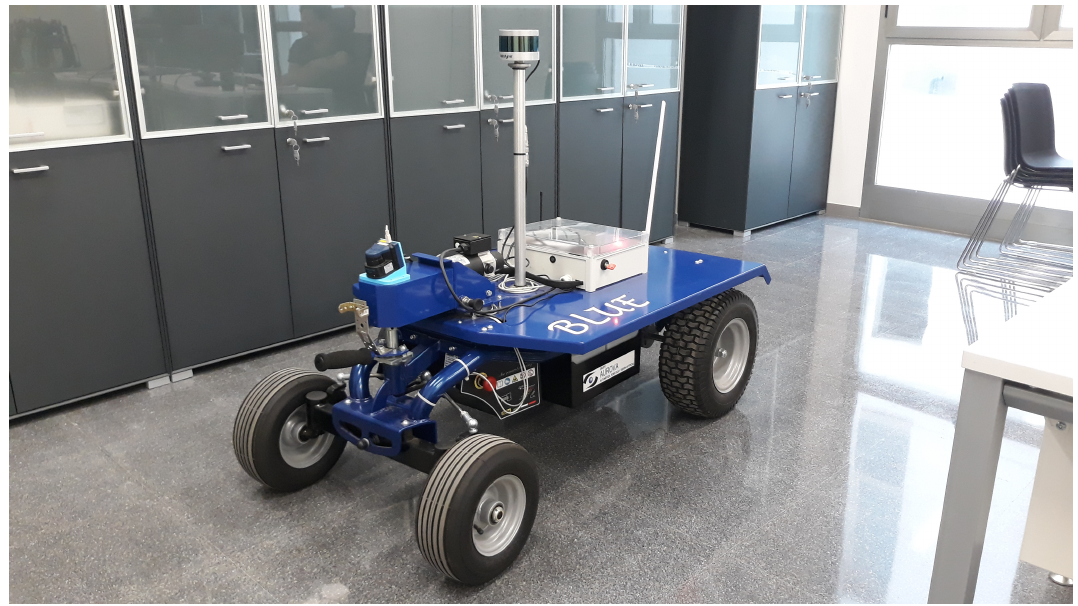
Figure 9. Experimental platform BLUE. This professional research platform—derived from a conventional electric cart—has been developed by our research group, in the University of Alicante. It is integrated with ROS and provides all the features required for developing state-of-the-art research in autonomous outdoor